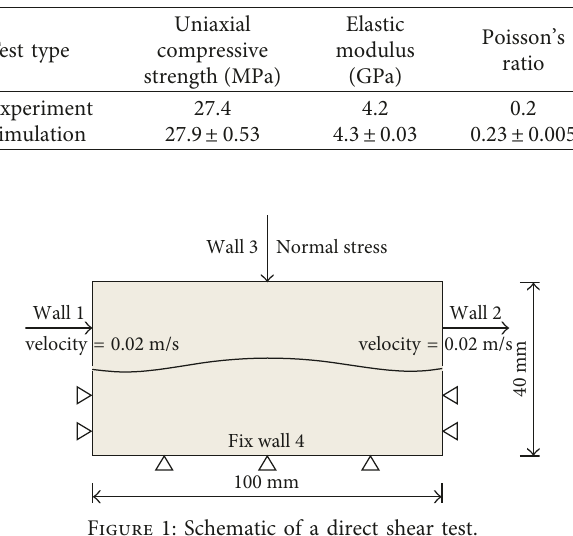
Table 2: Comparison of the numerical and experimental results.